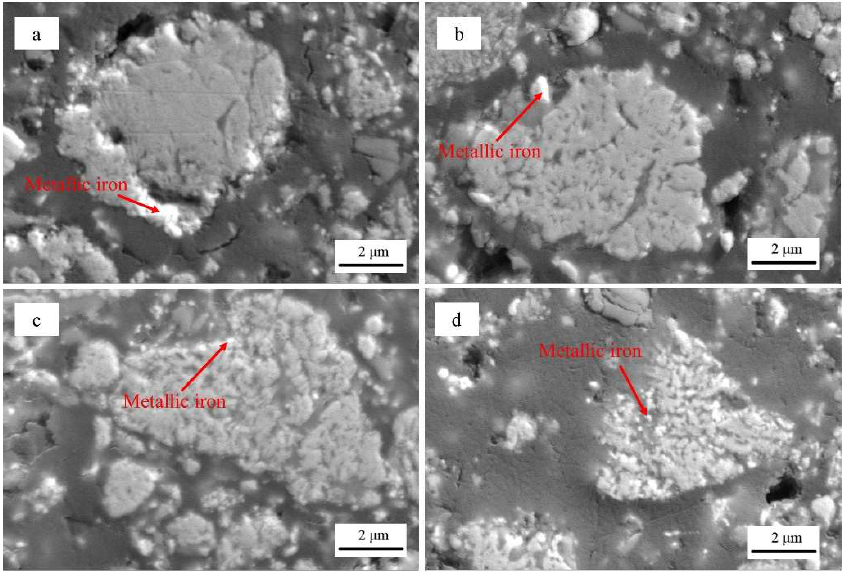
Figure 10. Microstructure after non-isothermal reduction with H 2 up to 1000 °C: ( a ) 5 °C·min −1 , ( b ) 10 °C·min −1 , ( c ) 15 °C·min −1 , ( d ) 20 °C·min −1 .